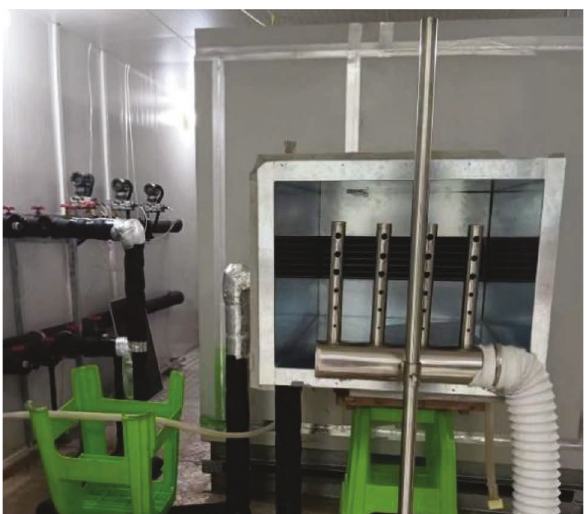
Figure 4: Physical photo of the experimental